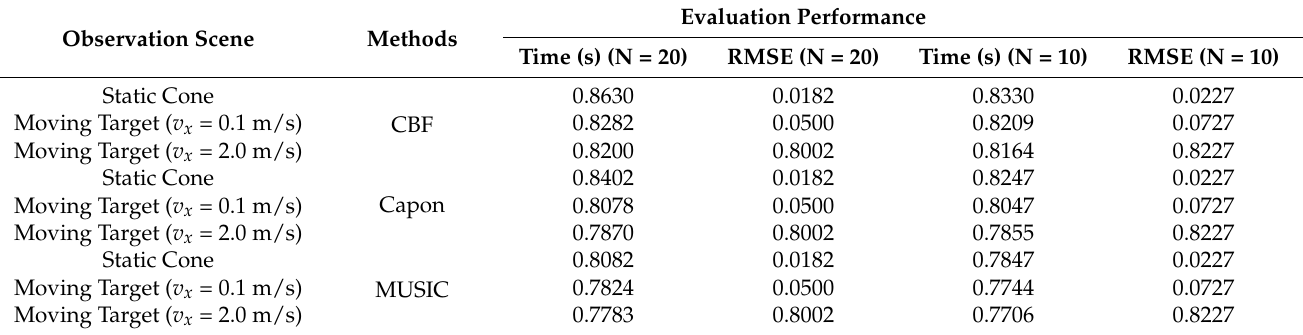
Table 4. Performance of the results.